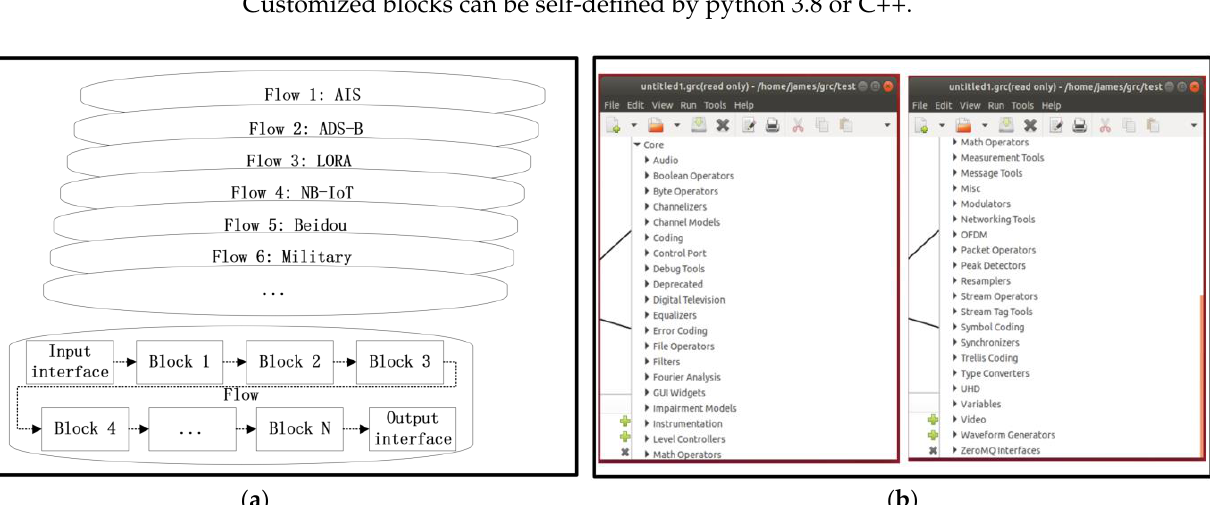
Table 5. RF front-end design parameters.